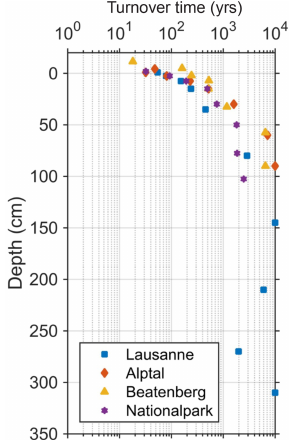
Figure 6. Modeled turnover times (yrs) of single profiles sampled down to the bedrock between 1995 and 1998; (cid:49) 14 C data published in Van der Voort et al. (2016). Results indicate the presence of petro- genic (bedrock-derived) carbon as modeled turnover time exceeds soil formation since the end of the last ice age (10000 years) in Lausanne ( > 100cm, Cambisol) and Alptal (80–100cm, Gleysol). For Beatenberg (Podzol) and Nationalpark (Fluvisol), no petrogenic carbon was